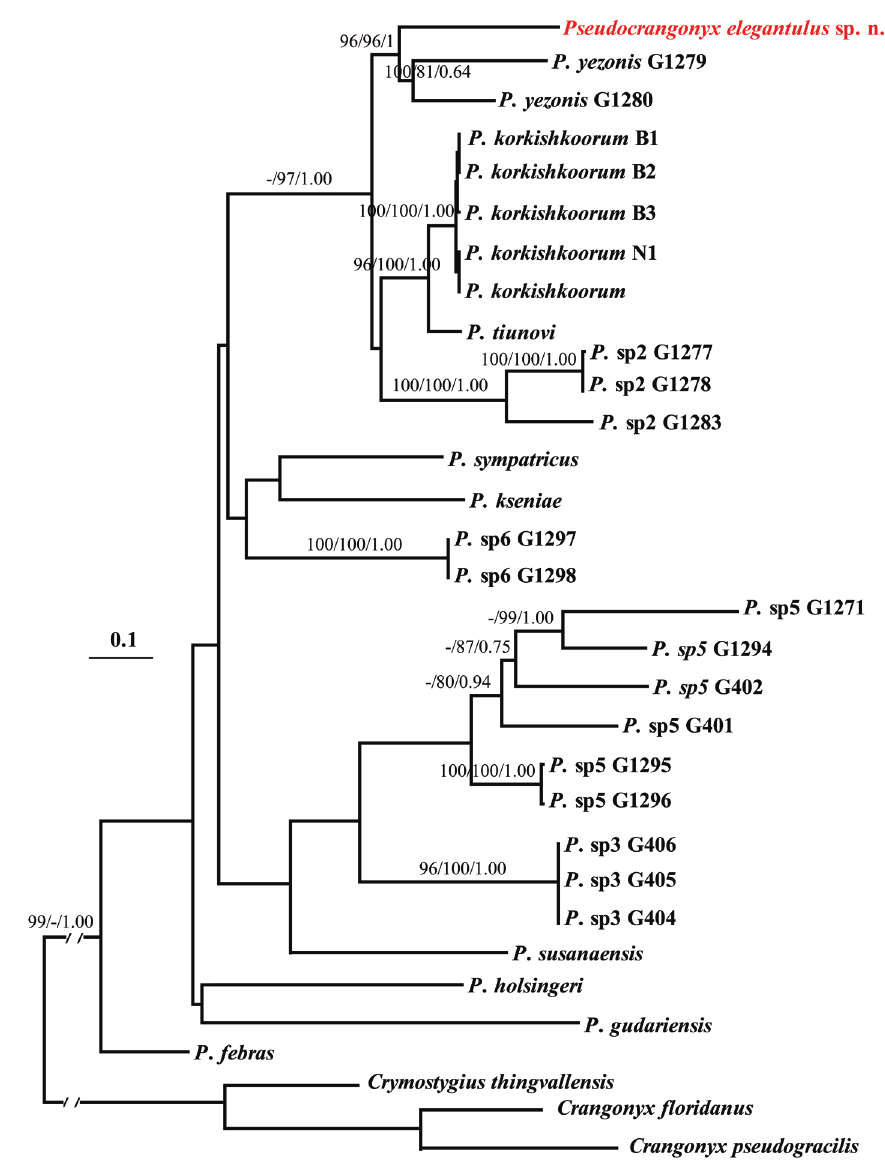
Figure 8. The ML tree derived from concatenated data set of 28S and COI. Support values greater than 70% are shown above branches in order for MP, ML, and BI analyses. Names of terminal taxa include voucher numbers for ingroups according to literature (Tomikawa et al.